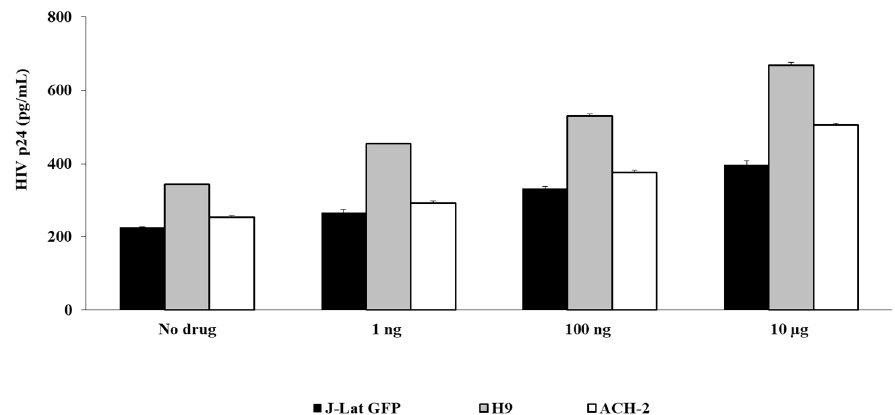
Figure 3. Lymphocyte cell lines ACH-2, H9, and J-Lat GFP were seeded at ~2 × 10 5 cells per well. Fentanyl at three di ff erent concentrations was added. After incubation with the drug for 24 h, HIV p24 protein (pg/mL) was quanti fi ed in culture supernatant. ANOVA for dose e ff ect: p = 0.001 for J-Lat GFP, p = 0.0045 for ACH-2, and p = 0.0062 for H9.